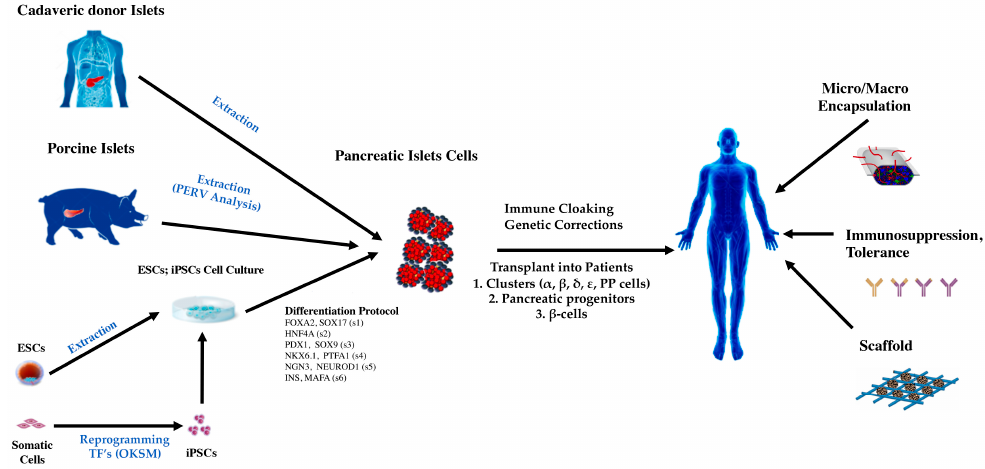
Figure 3. Islets obtained from the human or porcine pancreas can be transplanted to subjects with diabetes, following some form of immunosuppression. Human pluripotent stem cells can be differentiated into islet progenitor cells, pure beta cells, or mixed islet cells prior to implantation. Both donor pigs and pluripotent stem cells can be genetically engineered to improve survival, function, and cell safety. Cells can be micro, or macro encapsulated prior to implantation to reduce the requirement for chronic immunosuppression. The cells can also be incorporated into a scaffold to support cell survival and graft recovery. Differentiation Protocol is divided in sequential stages (s): FOXA2, Forkhead boxA2 and SOX17, SRY-box transcription factor 17, stage 1 (s1); HNF4a, Hepatocyte nuclear factor 4 alpha, stage 2 (s2); PDX1, pancreatic and duodenal homeobox 1 and SOX9, SRY-box transcription factor 9, stage 3 (s3); NKX6.1, Nirenberg and Kim homeo box 6.1 and PTFA1, pancreas associated transcription factor 1a, stage 4 (s4); NGN3, Neurogenin 3 and NEUROD1 Neuronal differentiation 1, stage 5 (s5); INS, insulin and MAFA, V-maf musculoaponeurotic fibrosarcoma oncogene homolog A, stage 6 (s6); ESC, embryonic stem cells; iPSC, induced pluripotent stem cells; TF’s: transcription factors; OKSM: octamer-binding transcription factor 4 (Oct4), Krüppel-like factor 4 (Klf4), Sex determining region Y-box2 (Sox2) and oncogene of myelomatosis (c-Myc). In protocols for the development of β -cells from pluripotent cells, six stages have been established using specific inducing factors to produce islets containing β -cells. Specific markers determined by flow cytometry or immunofluorescence microscopy are used to assess the progress and efficiency of the differentiation process [168–170]. The first three stages of differentiation generate a nearly homogenous (approximately 90% clonal) population of progenitors that express the master transcription factor PDX1. Thereafter, distinct populations are identified by staining for C-peptide,